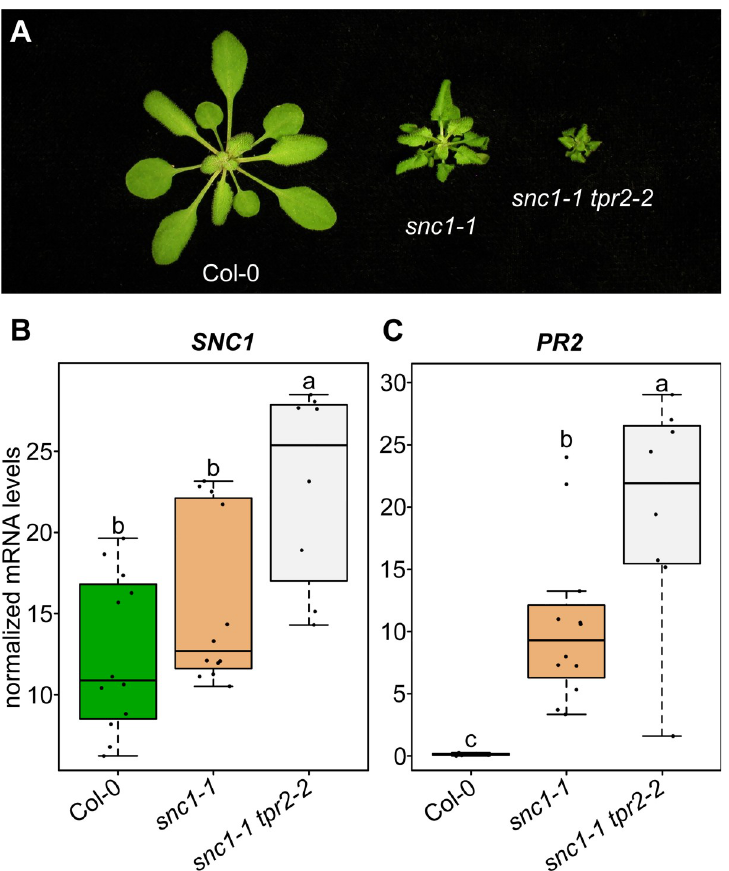
Fig 7. Mutations in TPR2 increase stunting and SNC1 expression in snc1 - 1 mutants. (A) Morphological phenotypes of snc1-1 and snc1-1 tpr2-2 . Plants were grown under short day conditions at 21˚C for four weeks. (B&C) Expression as measured by quantitative RT-PCR of SNC1 and PR2 . Dots represent individual data points taken over two separate experiments. Genes of interest were normalized against SAND (At2g28390). Whiskers on boxplots are drawn to the farthest data point within 1.5 � IQR of first and third quartiles. Letters denote significant differences as determined by Student’s t-test ( P < 0.01) using the Bonferroni-Holm method to correct for multiple comparisons.